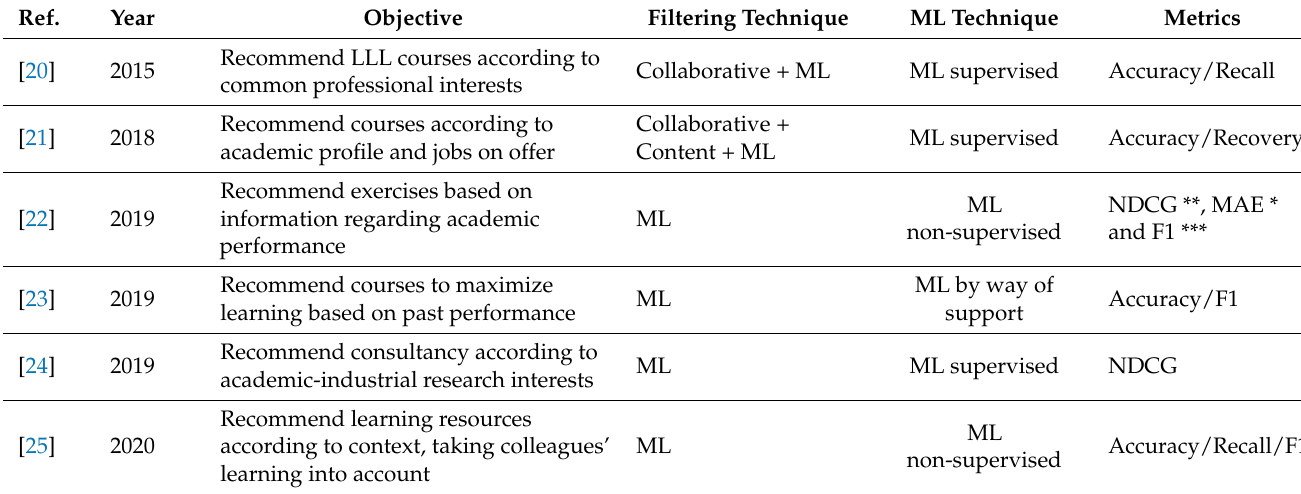
Table 1. Use of ML in recommender